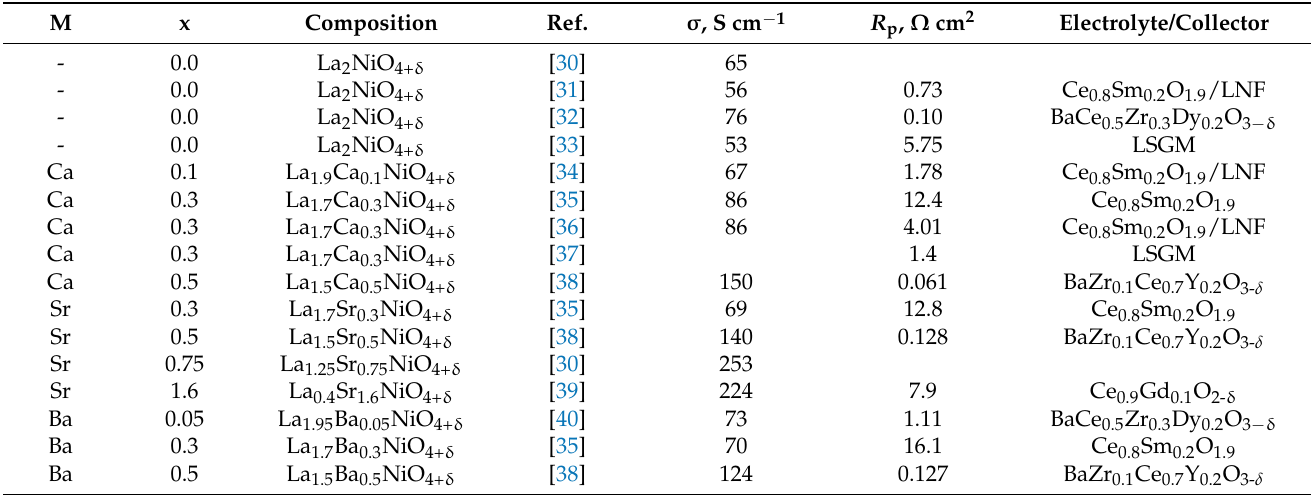
Table 1. Total conductivity and electrode polarization resistance of La 2 − x M x NiO 4+ δ (M = Ca, Sr, Ba) nickelates at 700 ◦